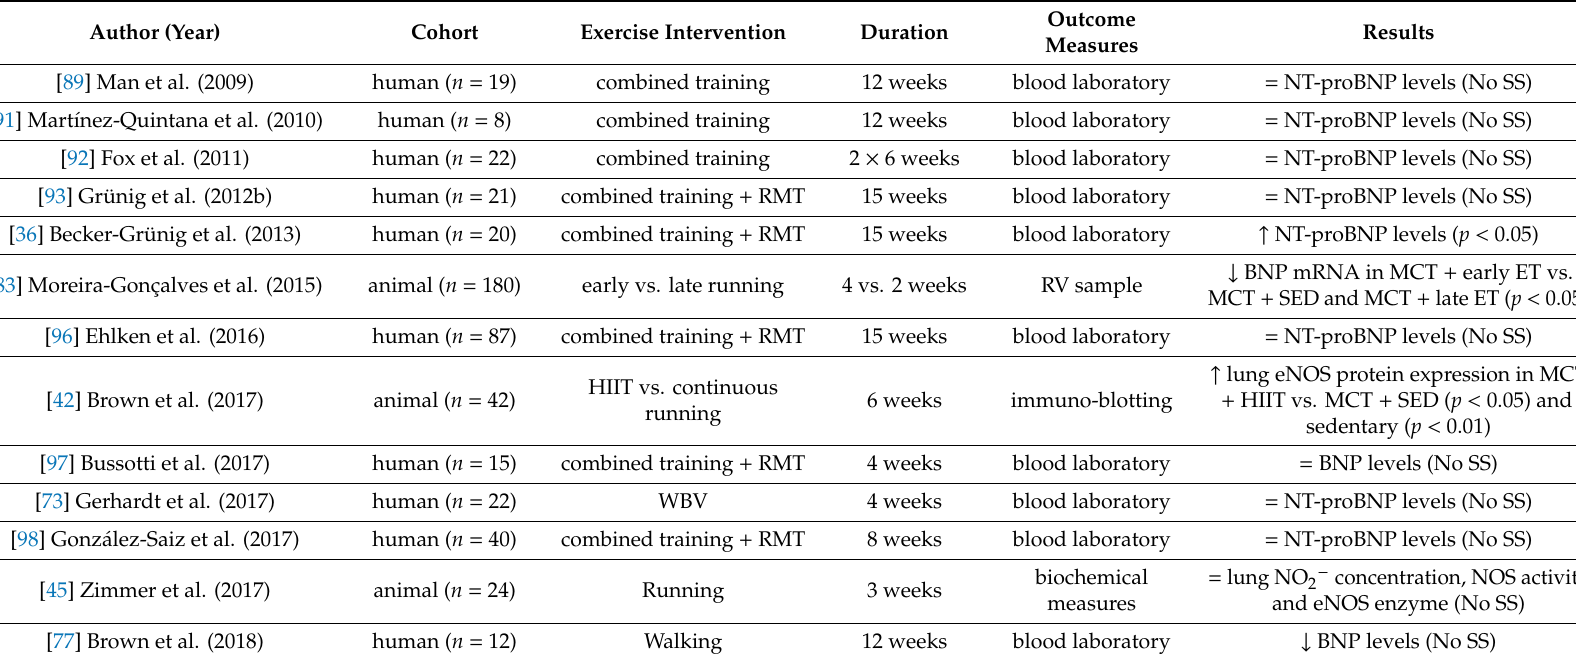
Table 6. Summary of studies examining molecular and cellular factors ( n =